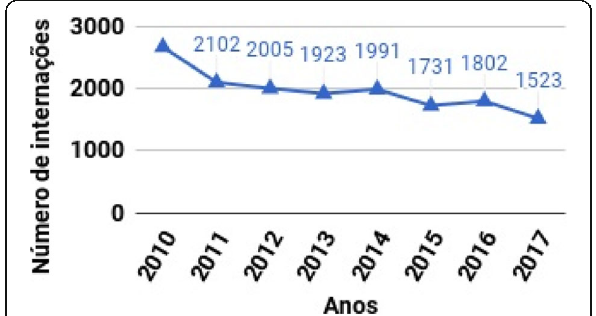
Fig. 1 (abstract P218). Number of hospital admissions caused by rheumatoid arthritis per